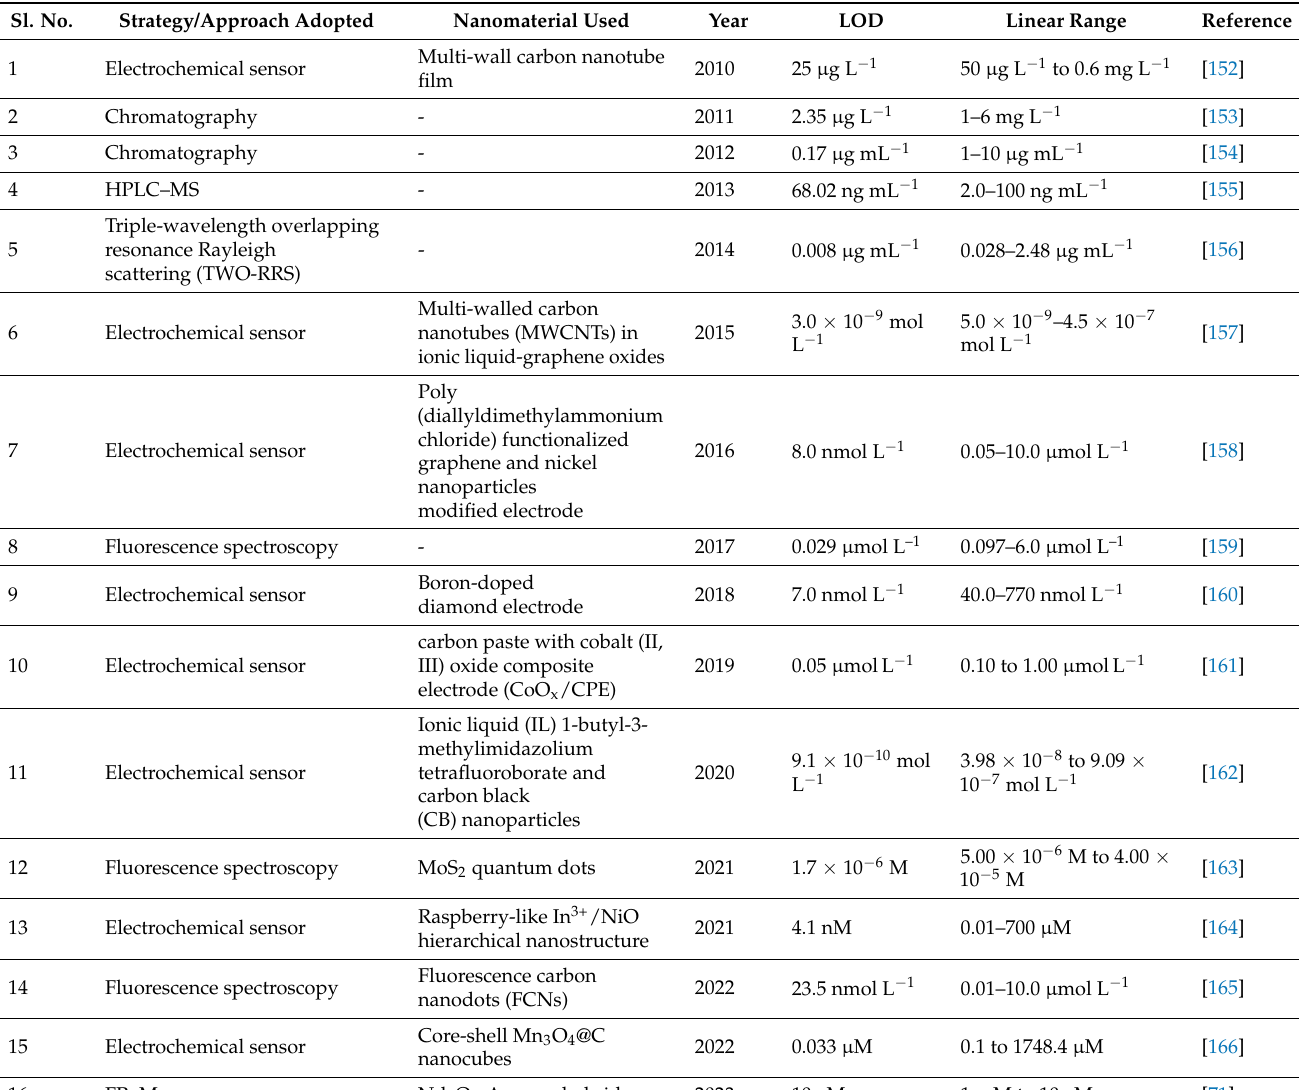
Table 2. Comparison of the performance of the techniques/strategies developed to detect allura red with the SPCE platform, presented along with their limit of detection (LOD) and the linear sensing